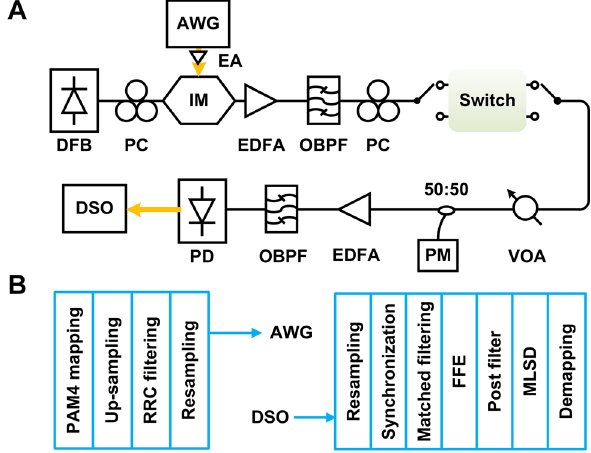
Figure 9: (A) Experimental setup and (B) digital signal processing (DSP) fl ow charts for the high data rate switching of the device. PM, power